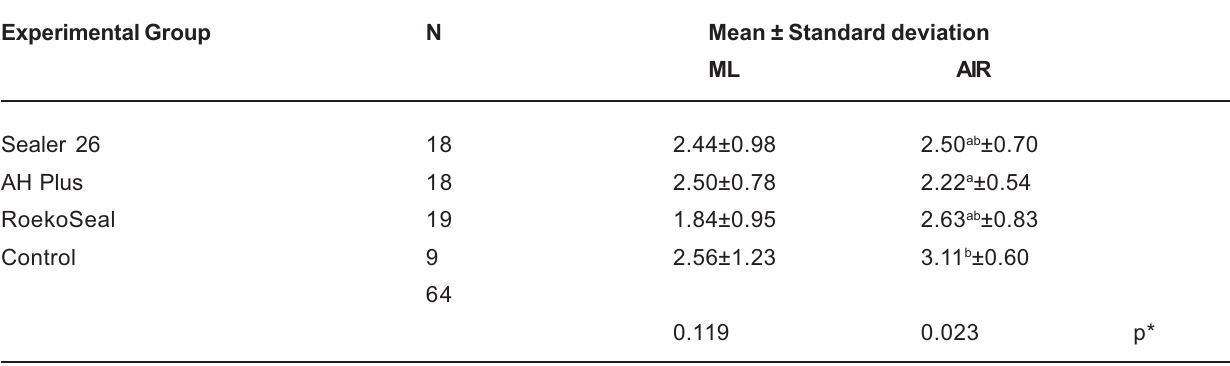
(*) ANOVA, α = 0.05. Different letters indicate statistically significant differences (Duncan’s post-hoc